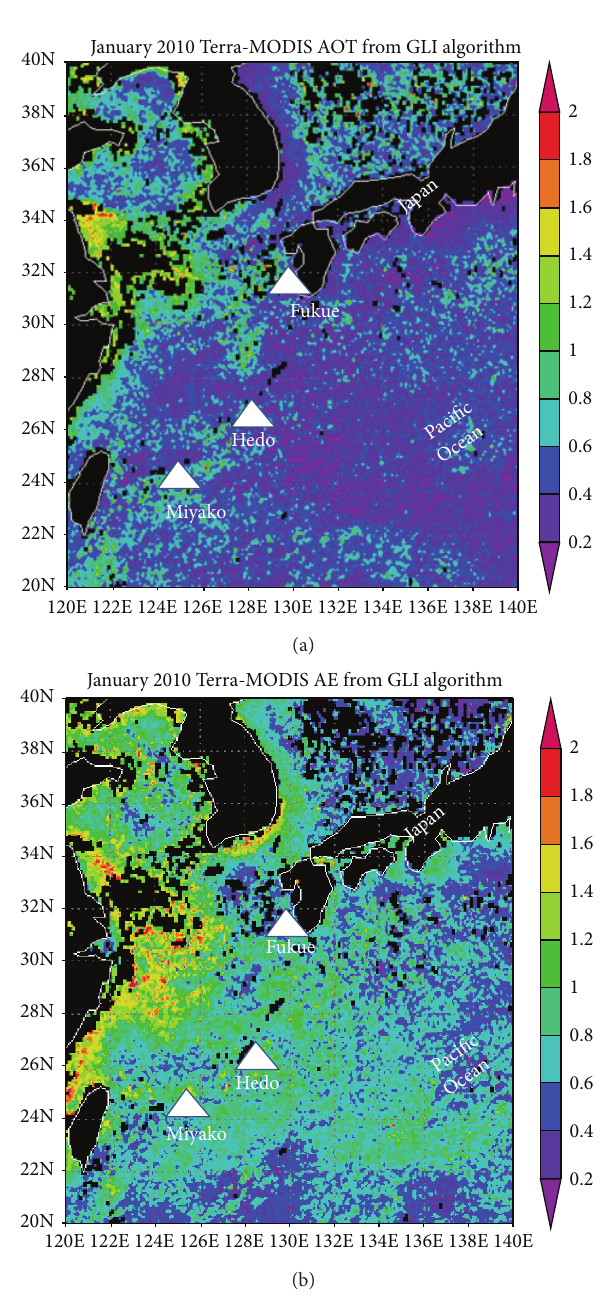
Figure1:GeographicallocationofthethreeSKYNETradiationsites (Fukue, Hedo, Miyako) used in this study to evaluate the satellite retrievals, over an image of satellite derived aerosols properties from the MODIS-GLI algorithm, for the month of January.